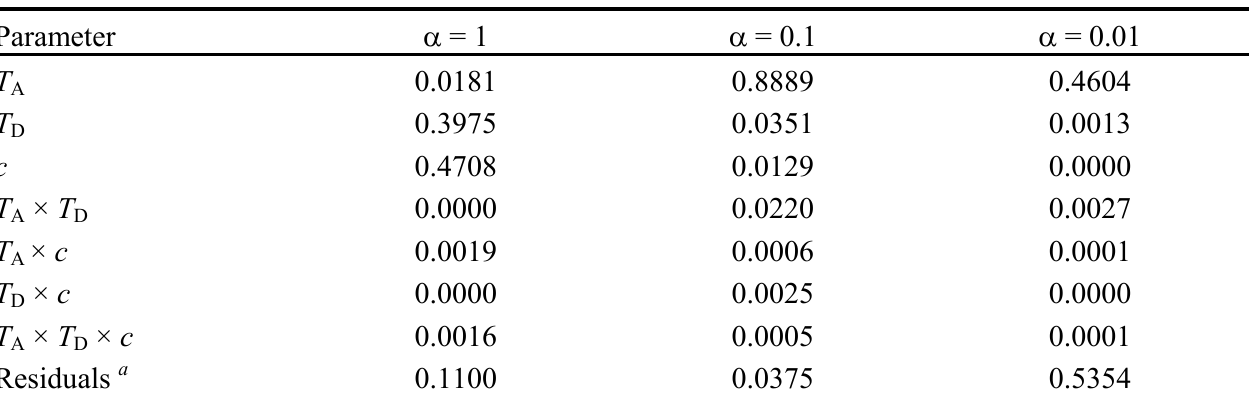
Table 3 . Analysis of variance for the effective number of gene trees ( G Table 1 for a detailed description of the IAA model